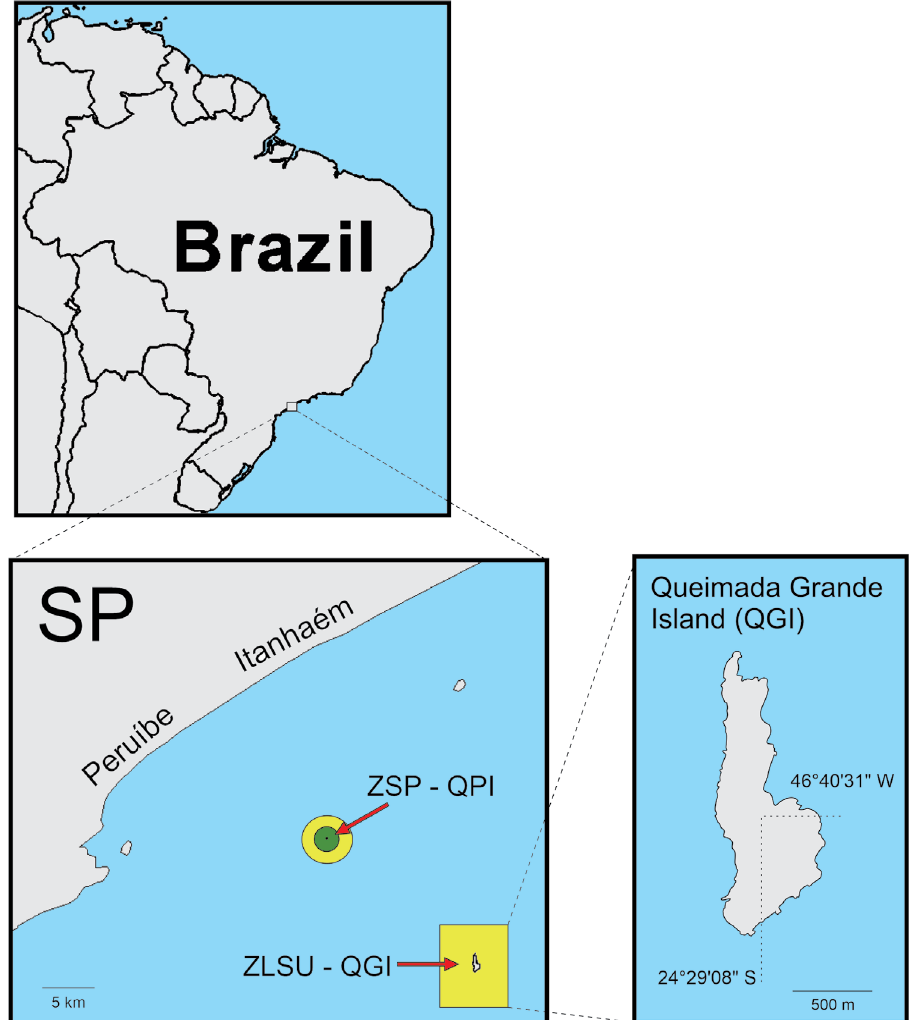
Figure 1. Sampling region in the Area of Relevant Ecological Interest (AREI) Queimada Grande and Queimada Pequena Islands and the Marine Environmental Protected Area “Litoral Centro” in the Zone of Special Protection (Queimada Pequena Island) and Zone for Low-Scale Use (Queimada Grande Island), southeastern